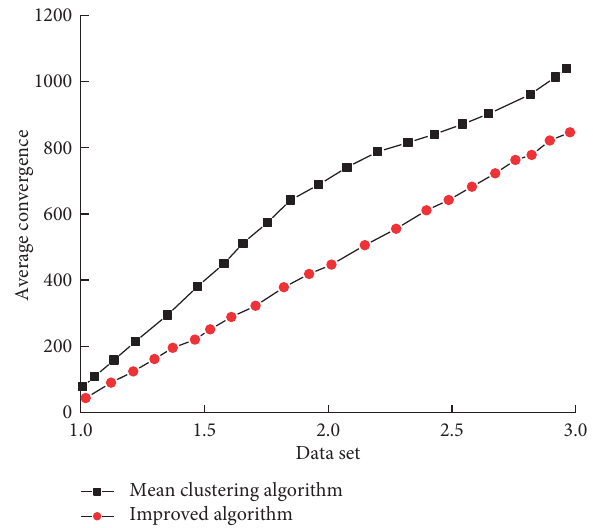
Figure 6: Average convergence of the algorithm.